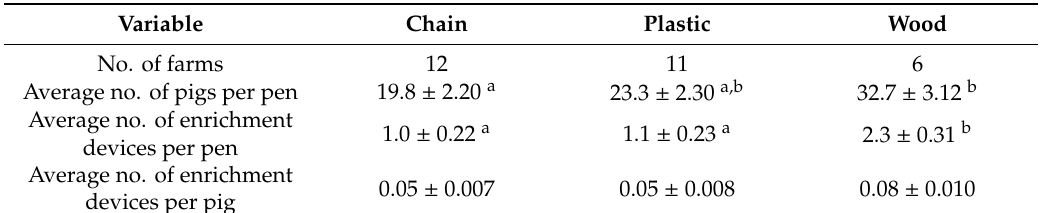
Table 4. Number of farms providing di ff erent types of enrichment (chain, plastic objects, wooden objects) and average number of pigs, enrichment devices and enrichment devices per pig (LS means ± SE) on 29 farrow-to-finish pig farms. Di ff erent superscript letters indicate significant di ff erences p < 0.05.